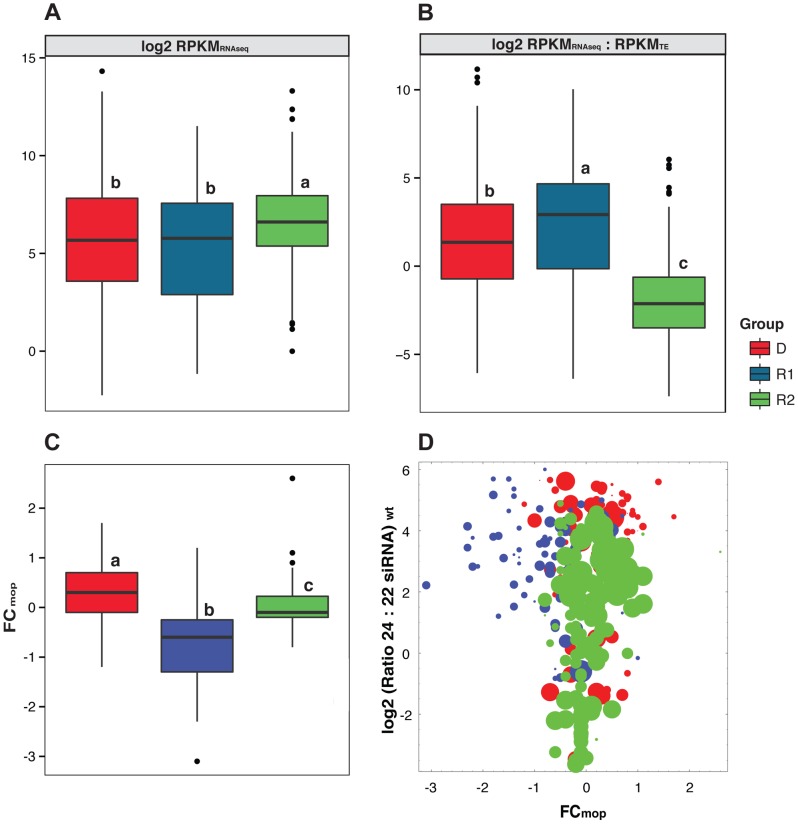
Expression characteristics of the three TE groups.a) Overall expression (RPKMRNAseq) and b) expression per TE copy (RPKMRNAseq : RPKMTE) for the three TE groups based on RNAseq data from transition leaves [57] c) Fold-change in TE expression (FCmop) between wild type (wt) and the mop1 mutant for a subset of 340 TEs [13]. d) A plot of FCmop and the 24∶22 nt siRNAs ratio for the same 340 TE subfamilies (dots). The diameter of the dots is proportional to the length of the TE exemplar. The boxes, whiskers and dots for the boxplots are defined in the caption of Figure 1, as are the lower case letters above the boxes.